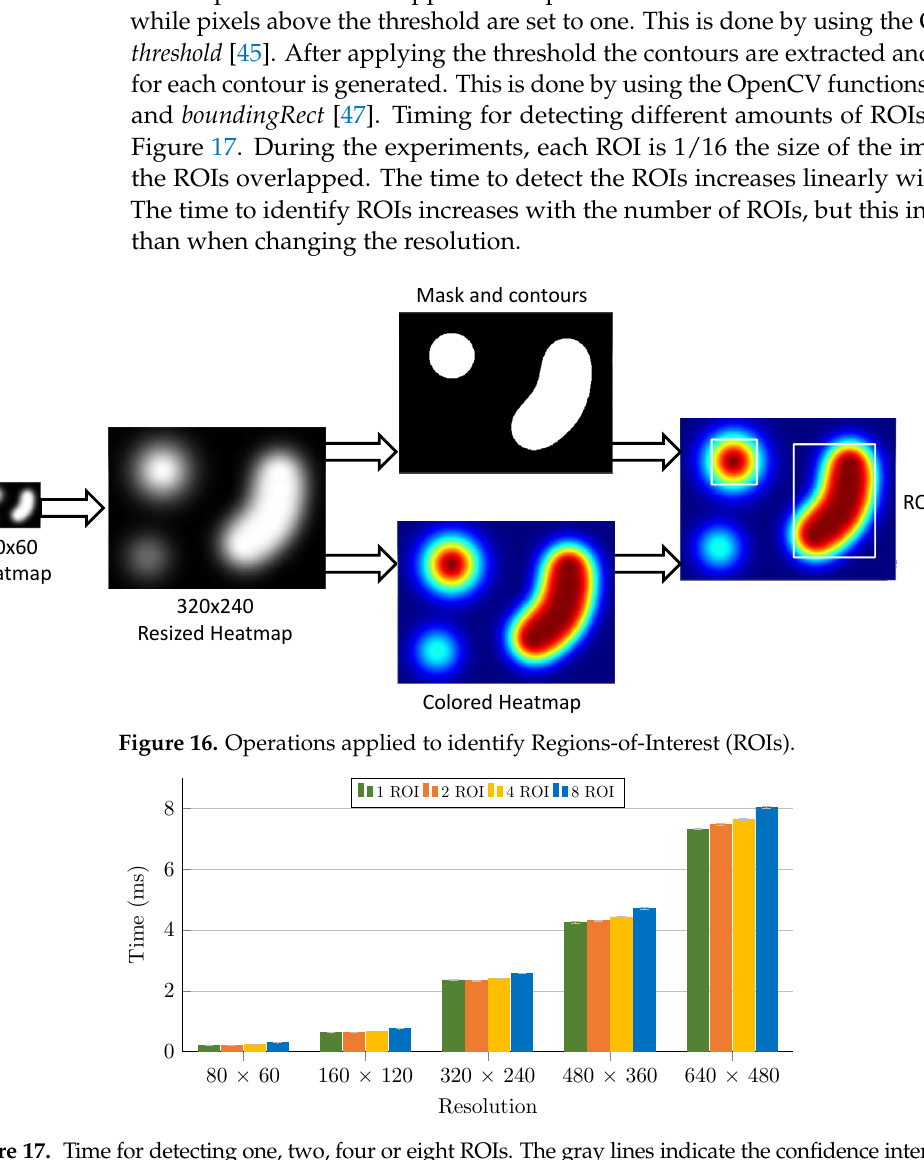
Figure 17. Time for detecting one, two, four or eight ROIs. The gray lines indicate the confidence